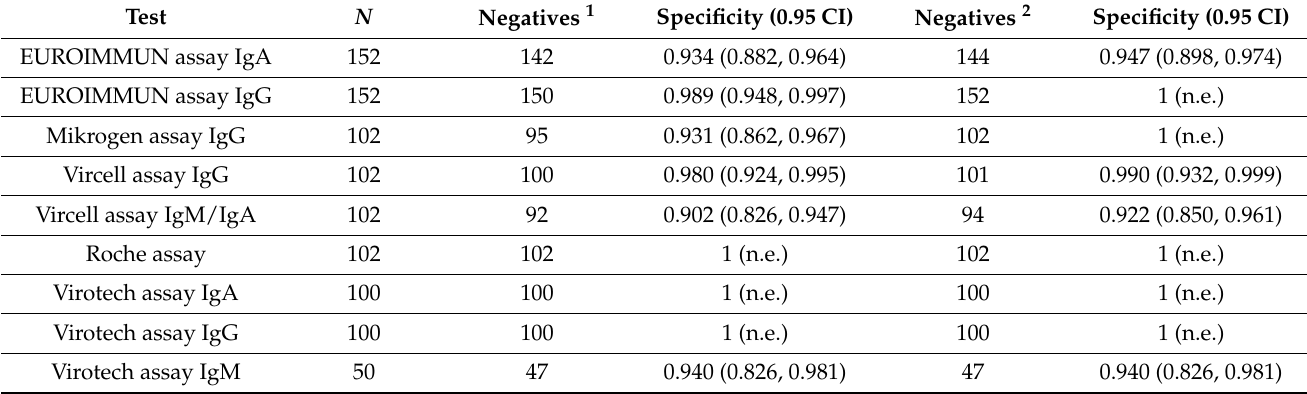
Table 3. Specificity of the test assays as calculated based on the blood donor